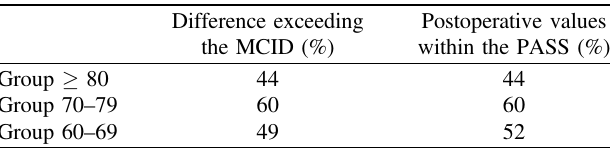
Table 11. Results of the EQ-5D index compared to PASS and